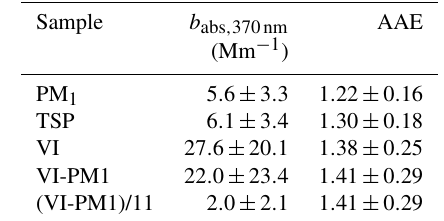
Table 2. Average absorption coefficient at 370nm, the absorption Ångström exponent (AAE), and their variations during the cam- paign (15 April and 6 May 2016). AAEs were calculated as averages of 1h values for the wavelength pair of 370 and